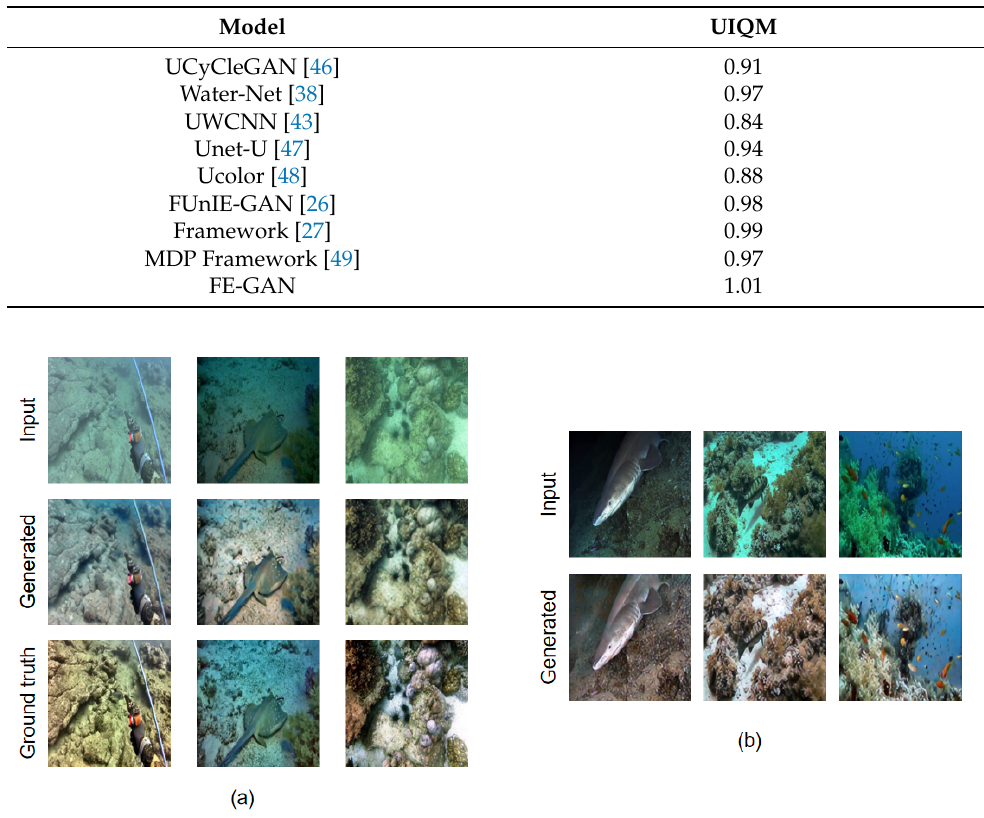
Figure 11. Generated results of Test-R90 ( a ), Test-C60 ( b